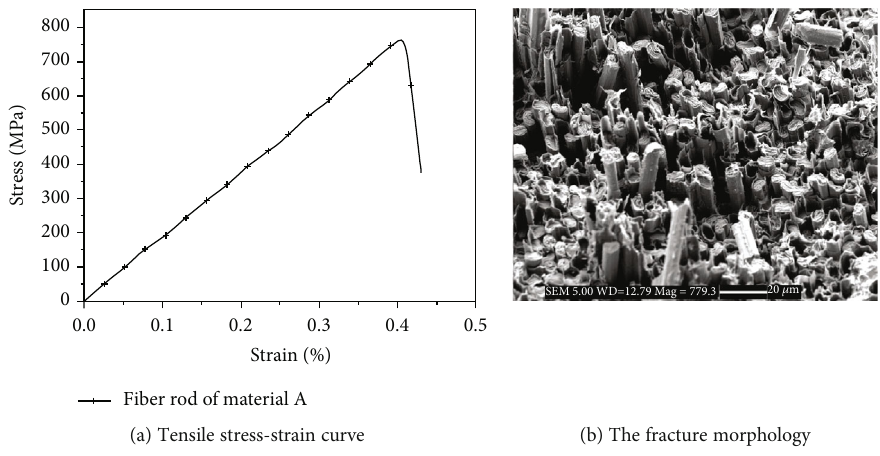
Figure 3: Tensile stress-strain curve of fi ber rod and fracture morphology after